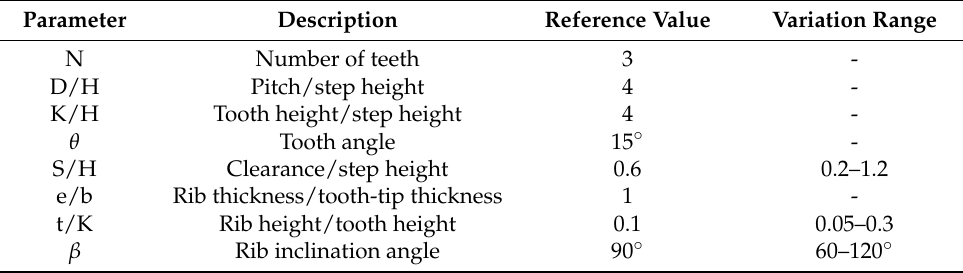
Table 1. Design parameters of the conventional and ribbed